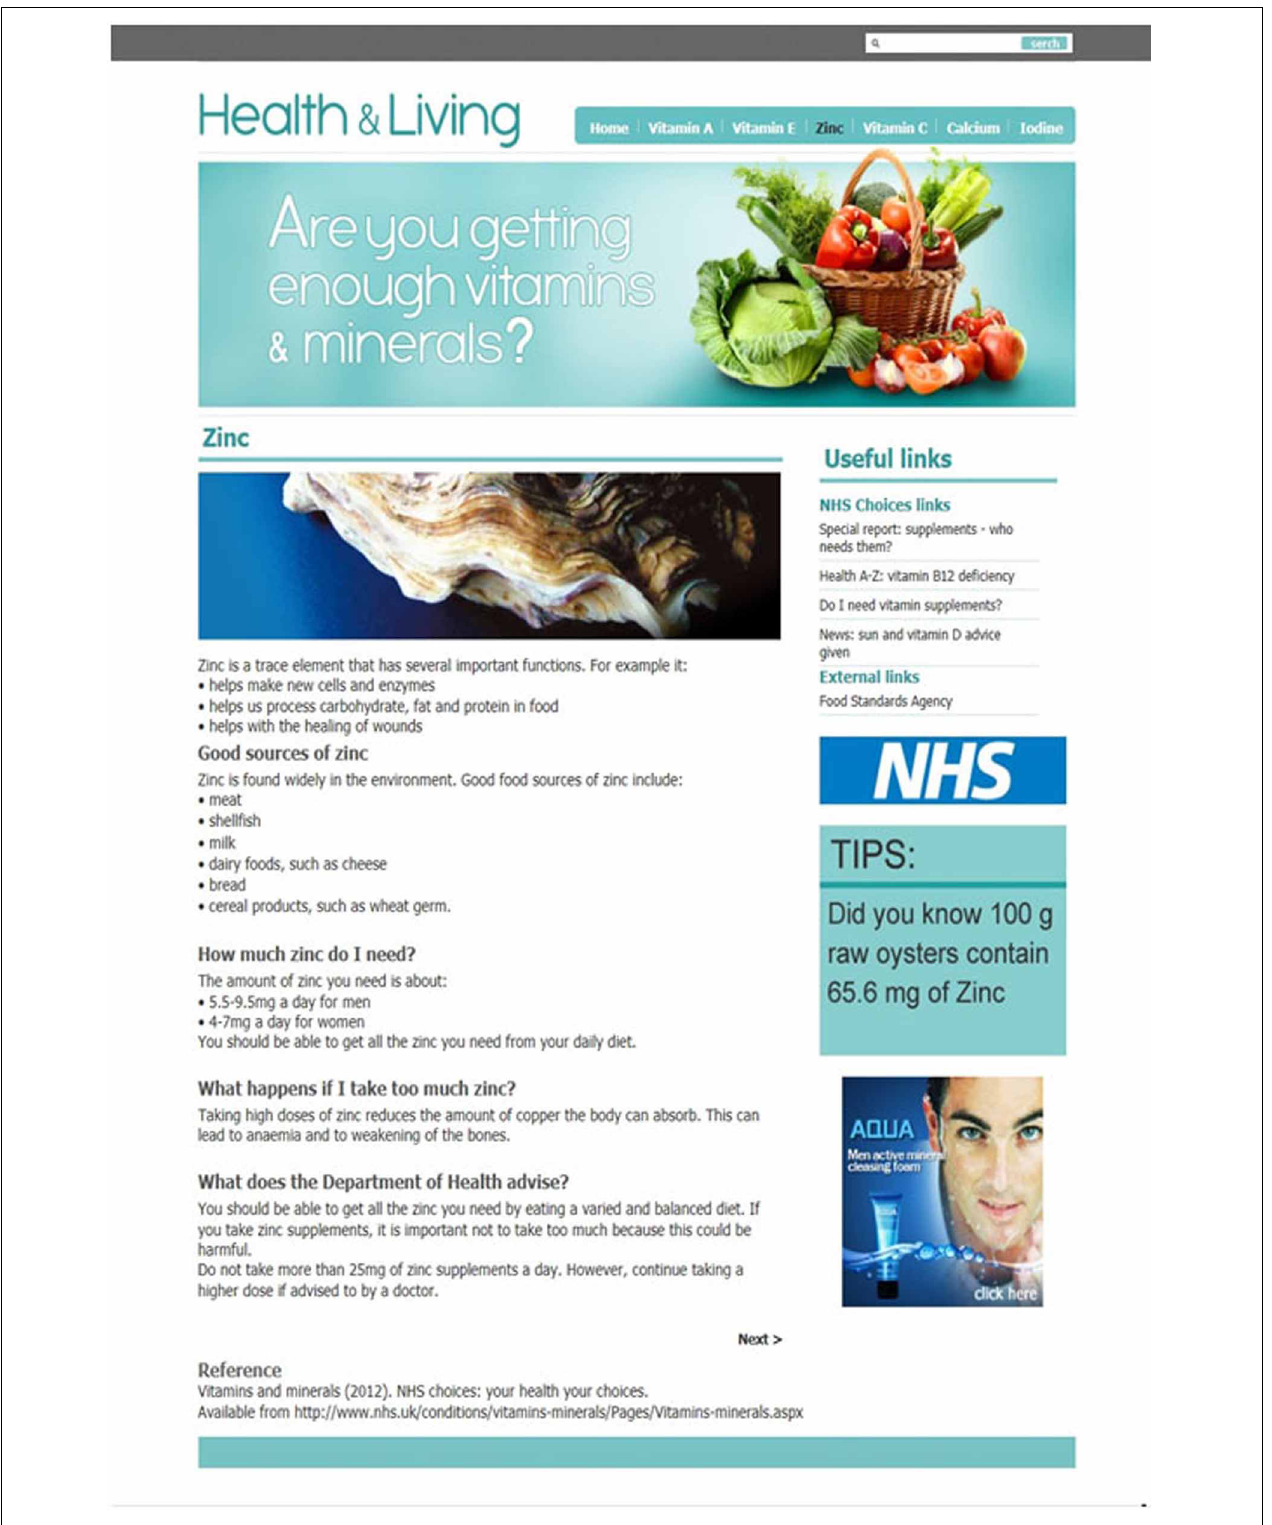
FIGURE 1 | An example webpage used in the experiment that presented information about zinc along with useful links and a vertical banner advertisement (located bottom-right).